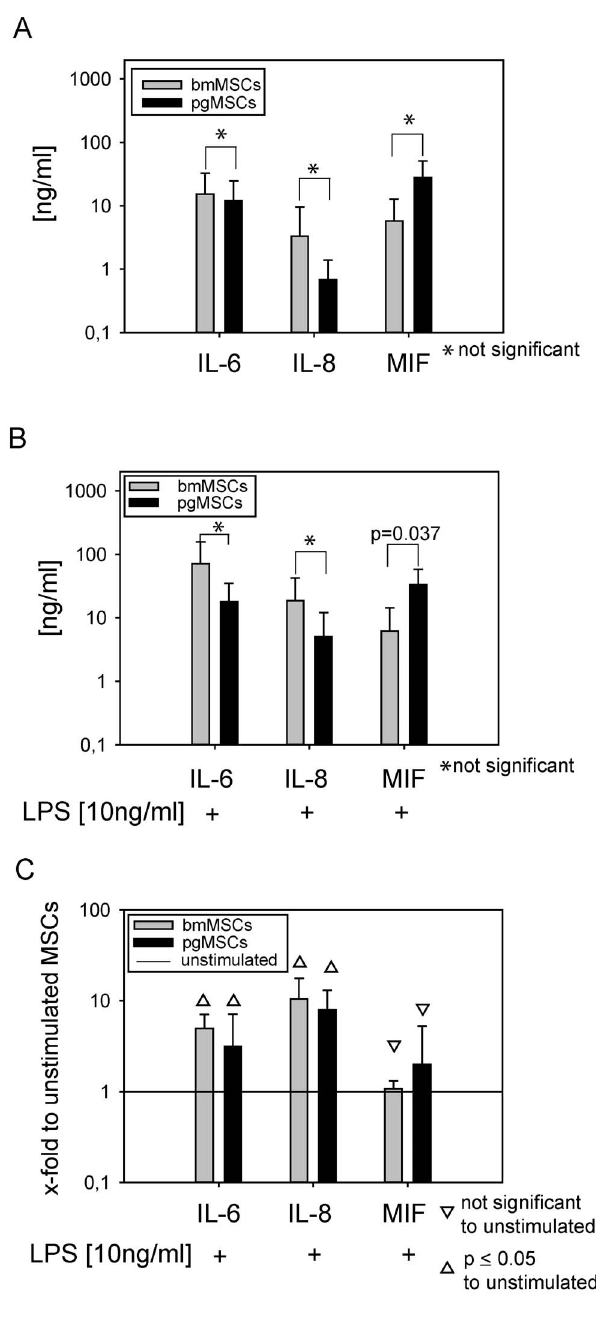
Figure 3. Cytokine secretion profile of bmMSCs and pgMSCs. Cytokines were quantified by ELISA. MSCs were (A) left untreated or (B/ C) were stimulated with LPS [10 ng/ml] (bmMSCs, n=7; pgMSCs, n=5; passage 3). (C) Cytokine secretion of untreated MSCs was set as 1 (reference value). Mann-Whitney test was used for statistical analysis; significance was set at the level of P #